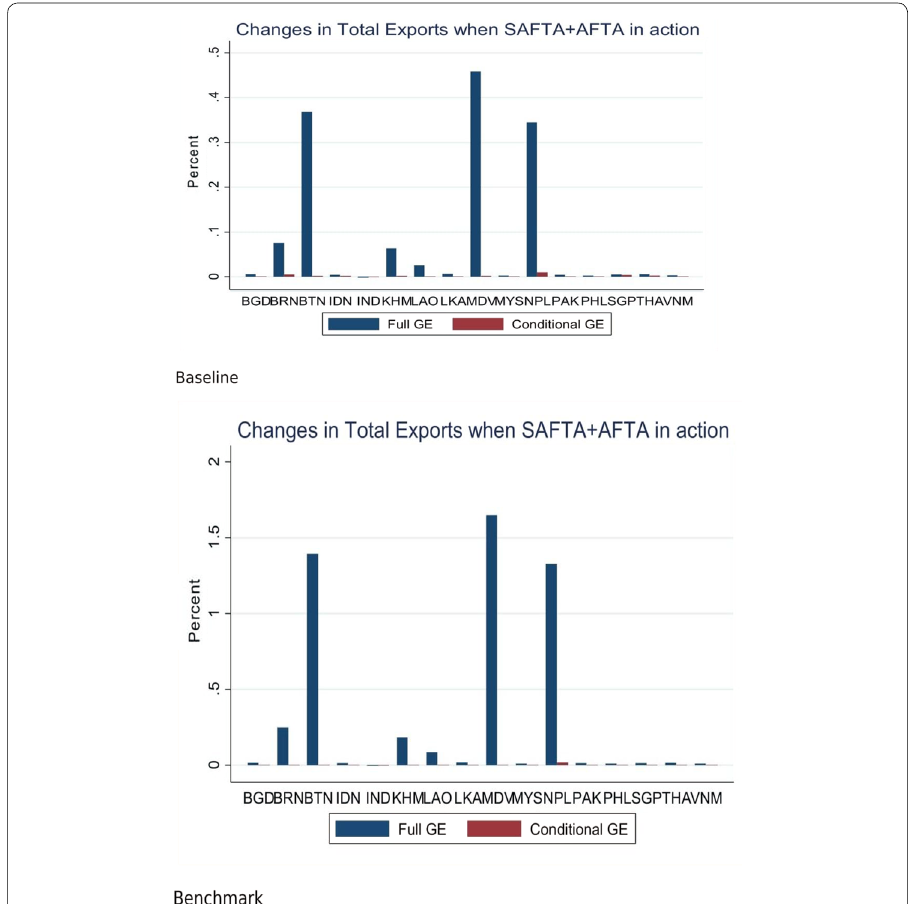
Figs. 5 and 6 Conditional and full GE impact of the joint SAFTA and AFTA on member countries’ export (baseline and